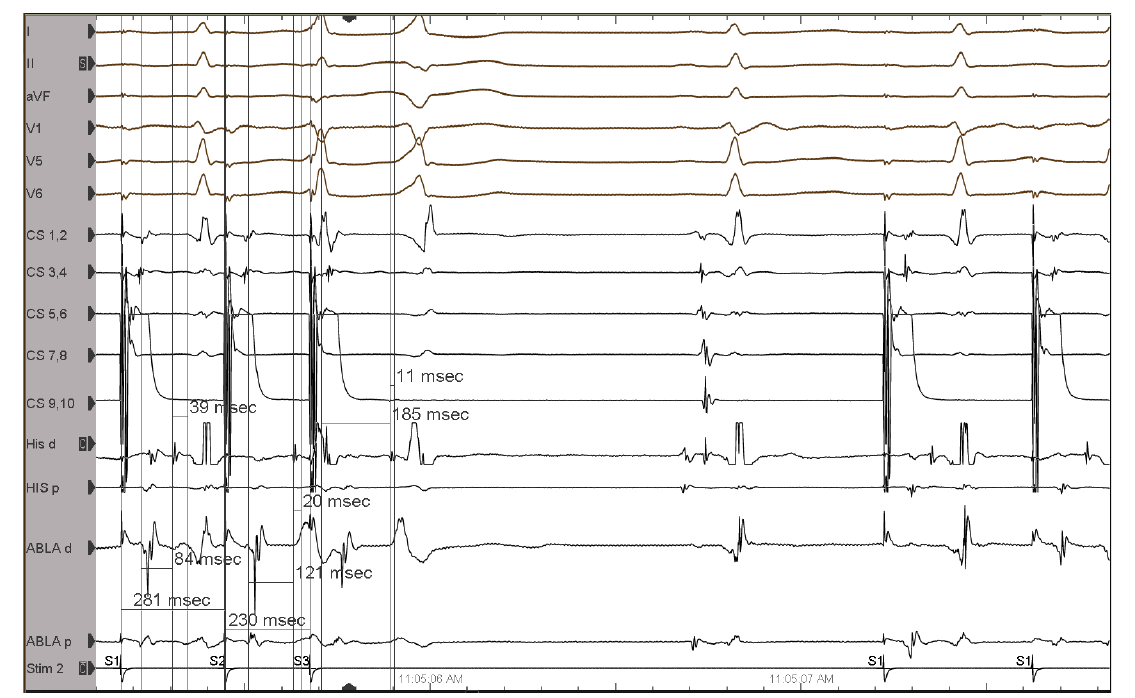
Figure 2. Programmed atrial stimulation with two premature stimuli: An extrastimulus is introduced from the coronary sinus at 340 ms after the last pacing drive stimulus (cycle length of 600 ms). This results in minimal pre-excitation: wider QRS, with a delta wave better visible in DI predominately negative in aVF and V1 (positive during the pacing drive and sinus rhythm); a second extrastimulus is delivered 10 ms earlier than the first (330 ms) and results in an atrial-His bundle (A-H) interval of 125 ms, longer than the A-H interval during the pacing drive (84 ms), and a His-ventricular (H-V) interval of 11 ms, shorter than that observed during the pacing drive (39 ms) de-fining an even greater degree of pre-excitation, with a clearly wider QRS. That electrophysiological behavior is the so-called Mahaim physiology of the accessory pathway. ECG leads from the top: DI, DII, aVF, V1, V5, V6. His d and His p indicate distal and proximal His bundle electrogram; CS 1-10, coronary sinus distal to proximal; Abla d and p, ablation catheter distal and proximal, respectively, placed in the RV.